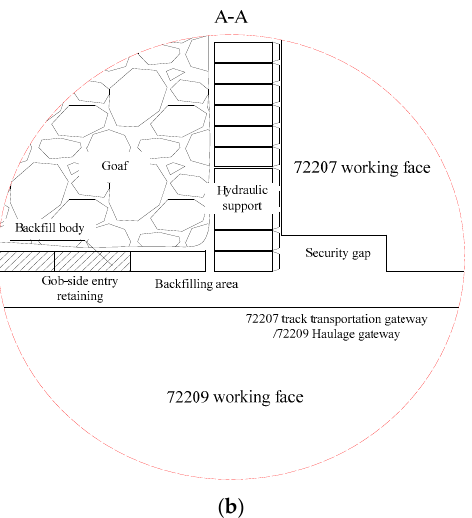
Figure 1. The plane view of the 72207 working face. ( a ) Schematic diagram of 72207 working face ( b ) A-A Profile.